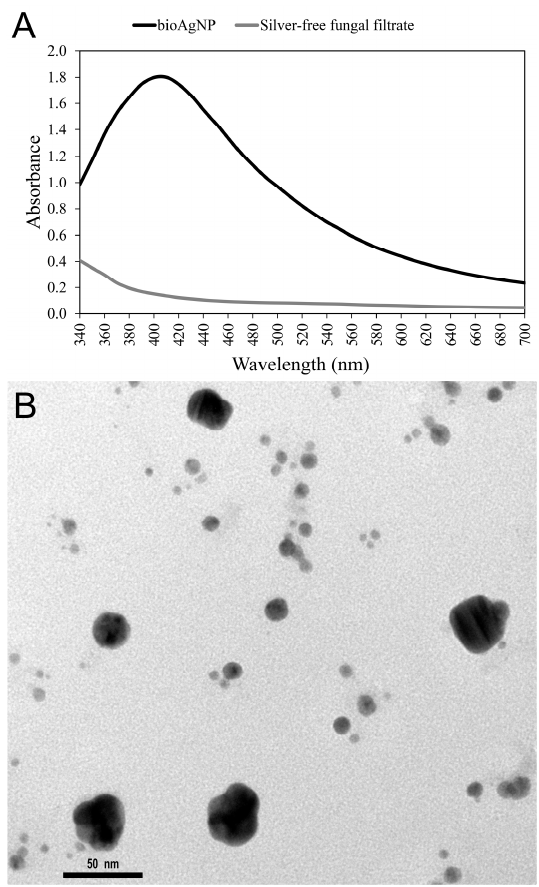
Figure 1. Characterization of biogenic silver nanoparticles (bioAgNP). ( A ) Plasmonic band: UV-Vis spectra show that the plasmon resonance of bioAgNP is centered at 420 nm, and this absorption peak is not observed for a fungal-free solution (negative control). ( B ) Morphology: MET micrograph of bioAgNP shows spherical nanoparticles. The size and zeta distributions of bioAgNP and calibration curve used to determine silver concentration are shown in Supplementary material.